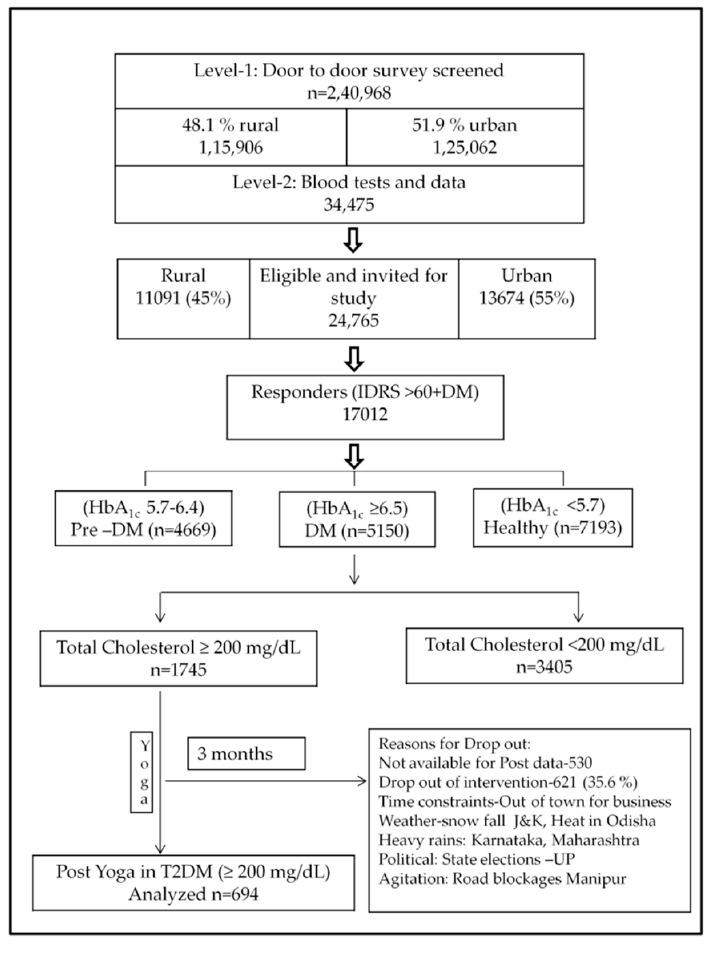
Figure 1. Study Figure 1. Study profile.